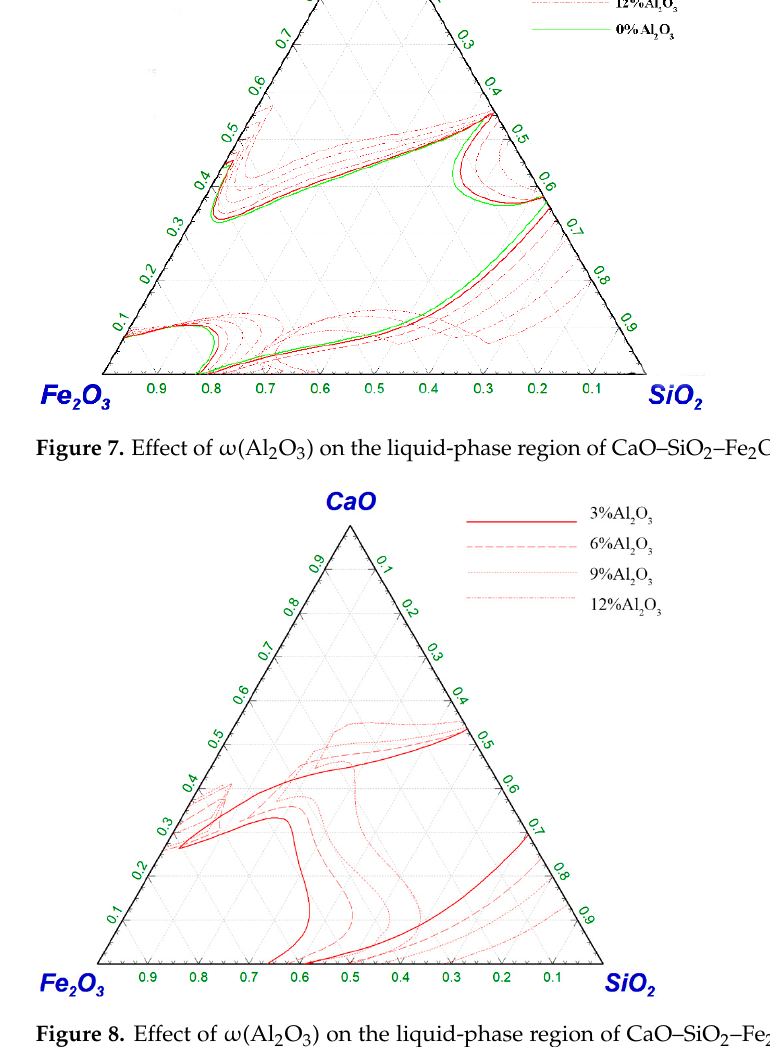
Figure 7. Effect of ω (Al 2 O 3 ) on the liquid-phase region of CaO–SiO 2 –Fe 2 O 3 slag system at 1450 °C.